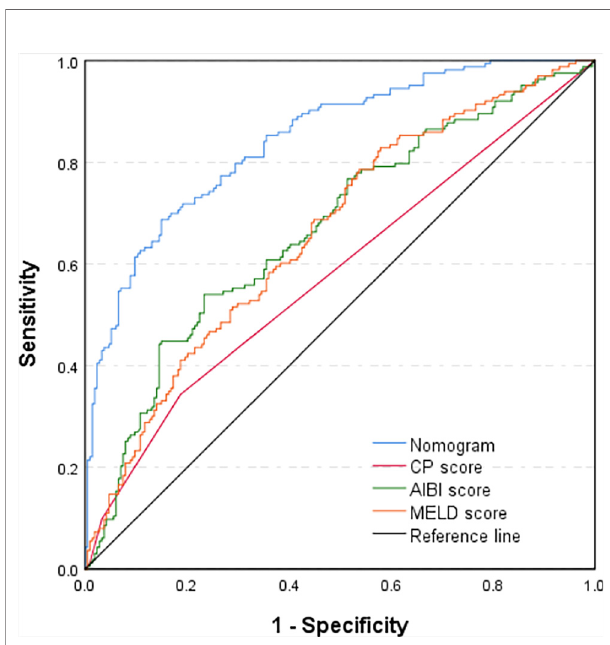
FIGURE 2 | Comparison of predictive accuracy for post-hepatectomy liver failure between the nomogram and the conventional models (CP score, MELD score, and ALBI score) by the training cohort.